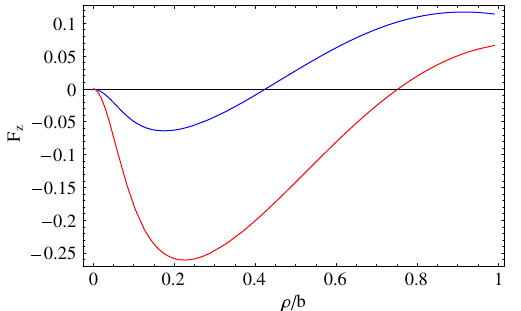
=b for p ¼ 0 . 1 . d